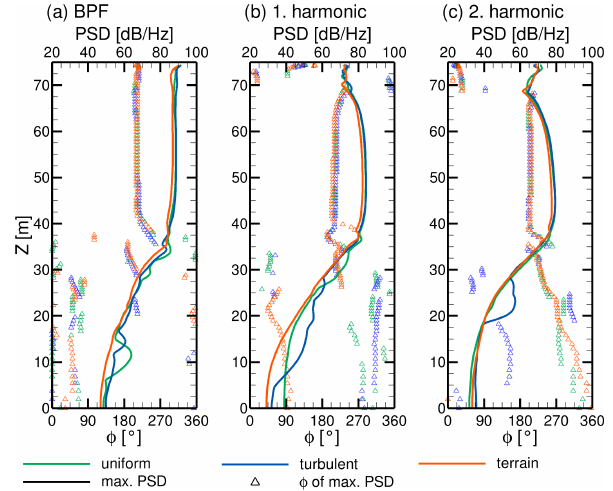
Figure 21. Maximum amplitude of the PSD of the surface pres- sure fluctuations per height and their circumferential position on the tower for the BPF (a) and first (b) and second (c) higher harmonic.